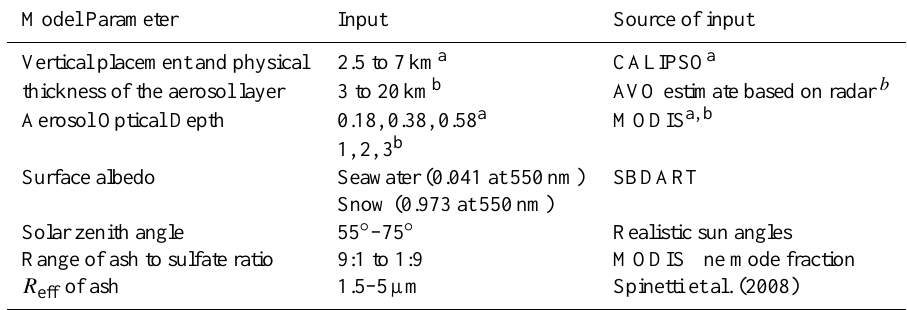
Table 1. Input parameters for SBDART. Sulfate size distribution was held constant at an effective radius of 0.5µm and σ of 0.5 (Kearney and Watson, 2009). For ash, σ is set to 0.59 and held constant for all simulations (Niemeier et al., 2009). Refractive indices for sulfate from OPAC were used for 70% sulfate solution. For ash, refractive indices of andesite from Pollack et al. (1973) were used. Model Parameter Input Source of input Vertical placement and physical 2.5 to 7km a CALIPSO a thickness of the aerosol layer 3 to 20km b AVO estimate based on radar b Aerosol Optical Depth 0.18, 0.38, 0.58 a MODIS a, b 1, 2, 3 b Surface albedo Seawater (0.041 at 550nm) SBDART Snow (0.973 at 550nm) Solar zenith angle 55 ◦ –75 ◦ Realistic sun angles Range of ash to sulfate ratio 9:1 to